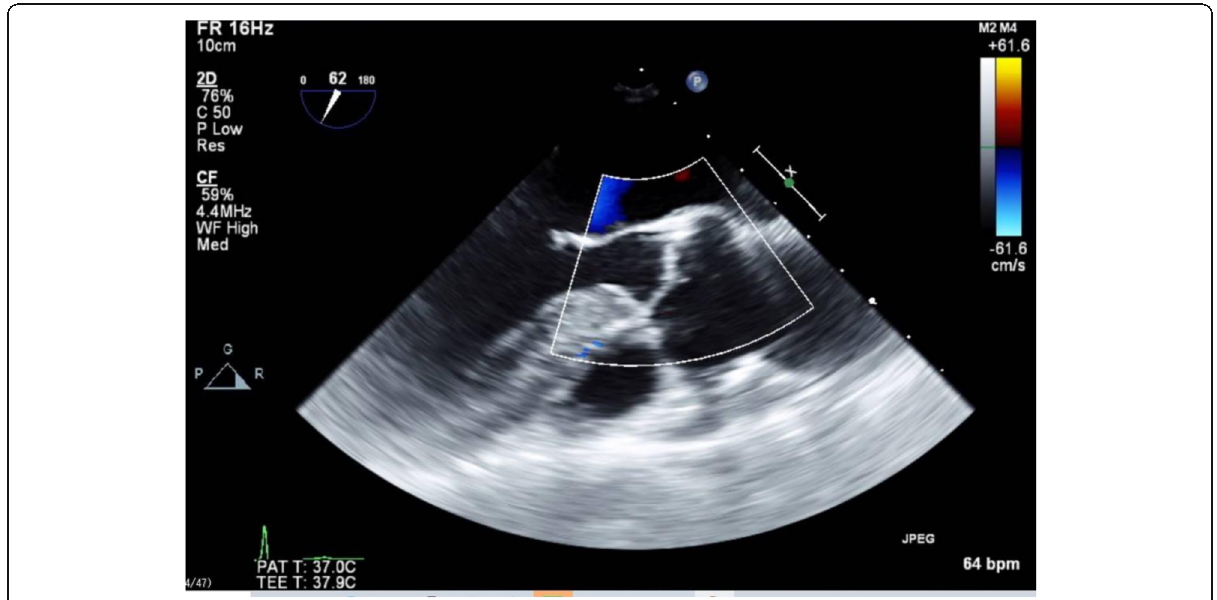
Fig. 7 The aortic valve long-axis view, normally found at 120°, was obtained at